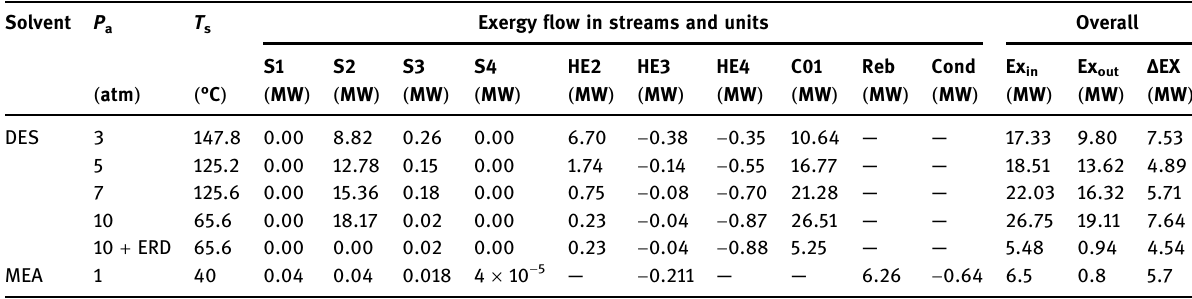
Table 4: Exergy fl ow and overall exergy loss of CO 2 capture process Solvent P a